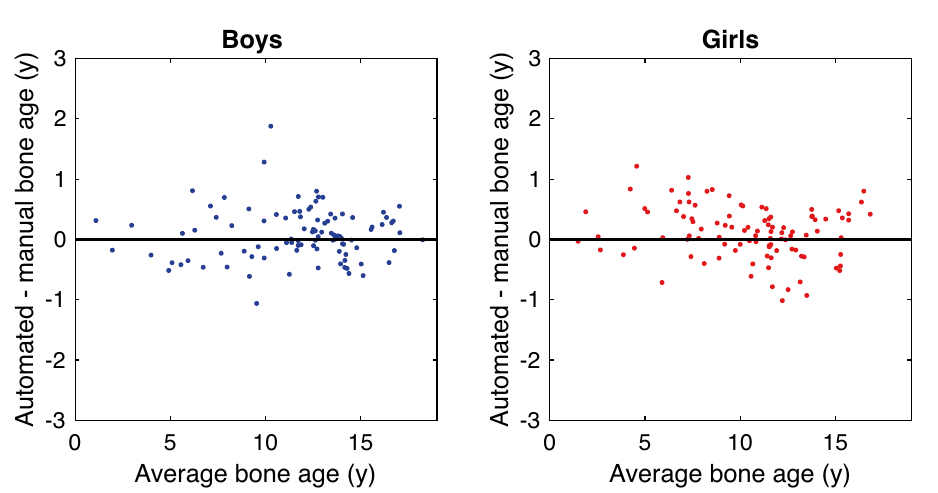
Figure 4. Bland Altmann plot for the agreement between the automated rating and the manual rating for the 200 cases in the RSNA test